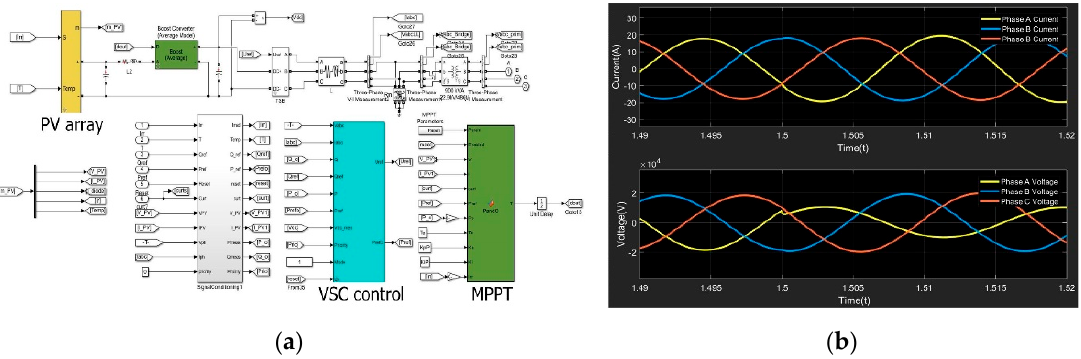
Figure 9. Modeling of a PV system. ( a ) PV system in Simulink. ( b ) PV control characteristics in the fault condition.